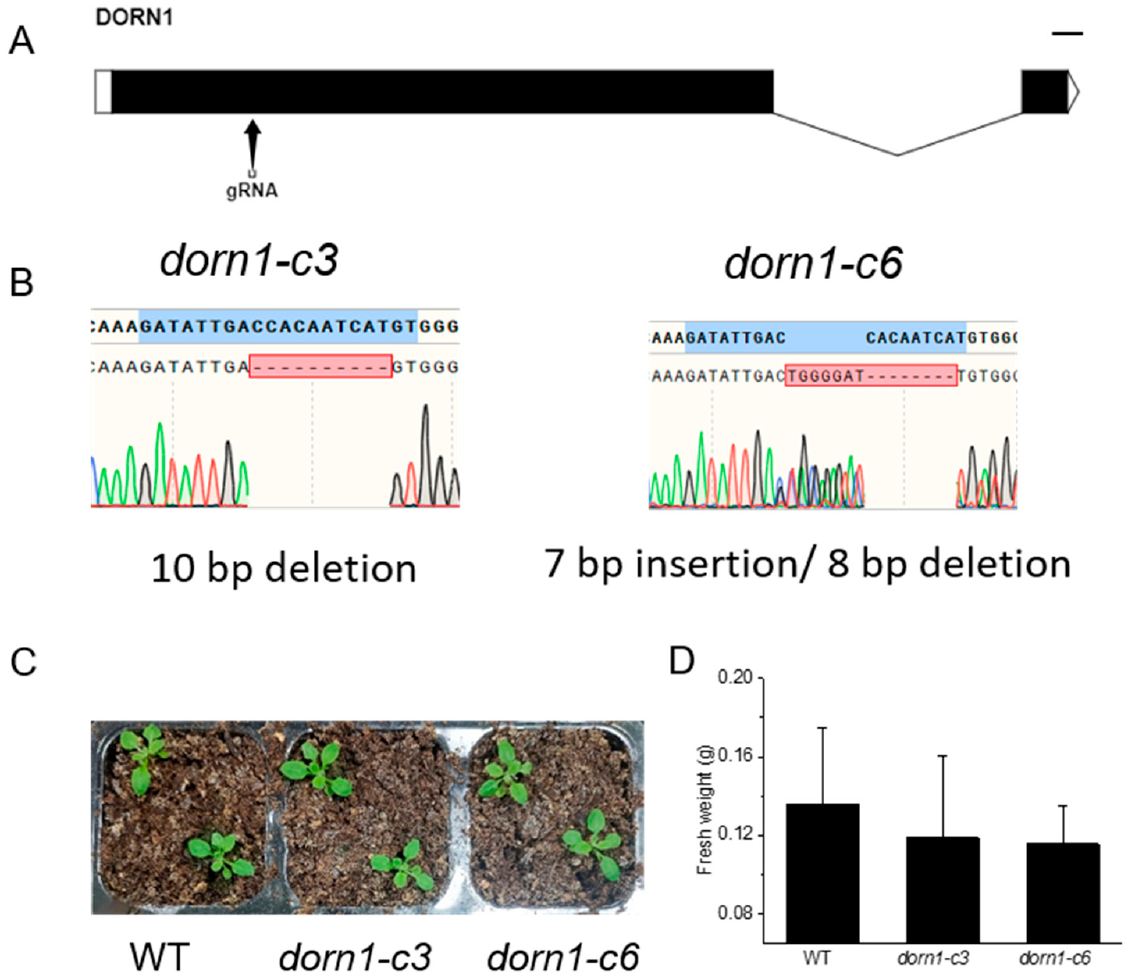
Figure 1. The dorn1 mutants showed no obvious phenotype under normal growth conditions. ( A ) Gene structure of DORN1 and the Cas9/guide RNA target site. ( B ) Mutation site information of the dorn1-c3 and dorn1-c6 , dorn1-c3 characterized a 10 bp deletion and dorn1-c6 with 7 bp insertion/8 bp deletion. ( C ) The dorn1 mutants grew well under normal culture conditions. ( D ) Statistical analysis of fresh plant weight. Each data point represents the average fresh weight of ~15 seedlings of three duplicate experiments, and error bars represent the standard deviation (SD).